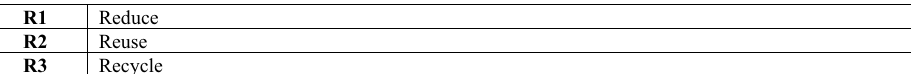
Table 2. The 3 Rs.